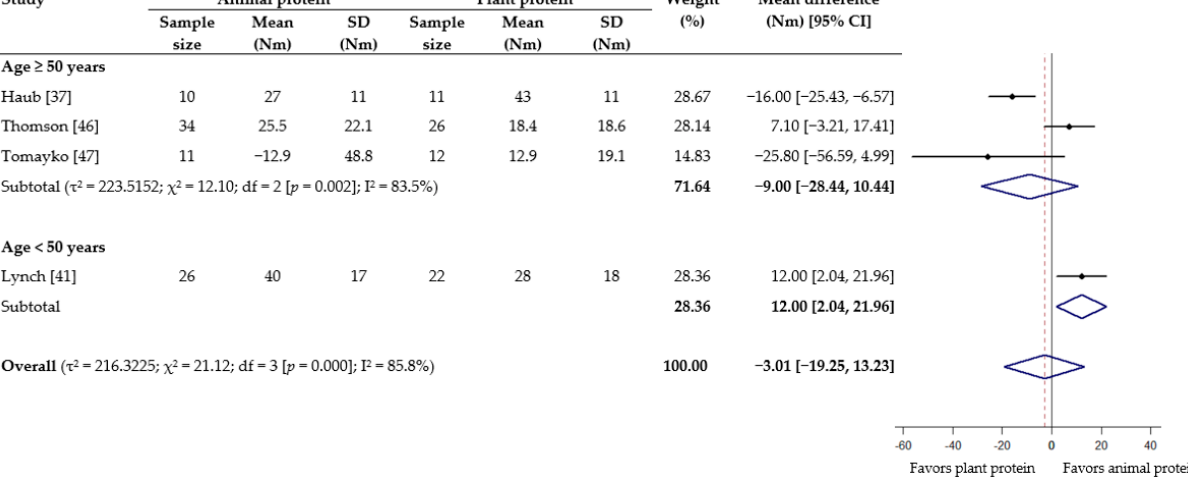
Figure 6. Effect of consuming animal protein compared to plant protein on changes in peak torque of leg/knee flexion (Nm) based on age group. Data expressed as weighted mean differences with 95% CIs, using a random ‐ effects model. Nm: Newton meter.